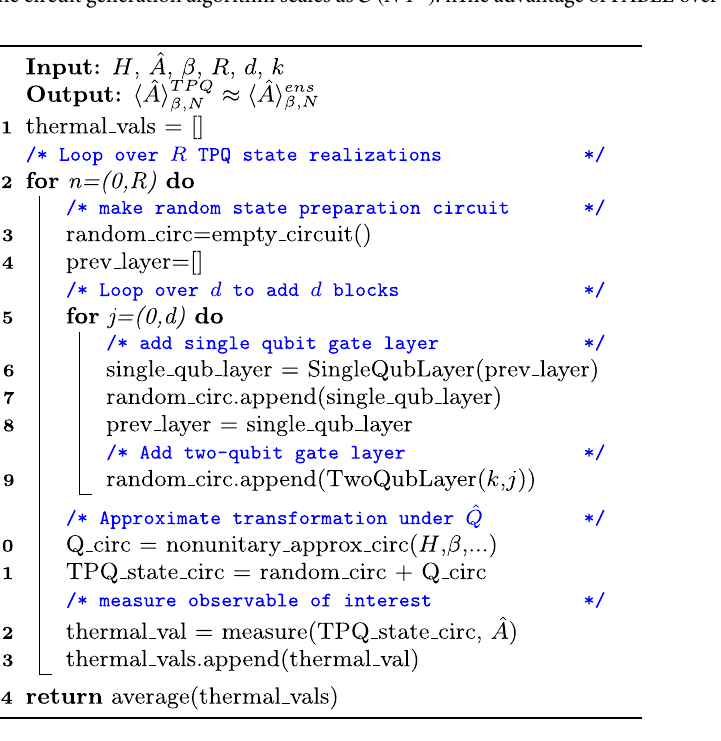
Figure 2. Pseudocode algorithm for computation of thermal averages with canonical TPQ states on quantum